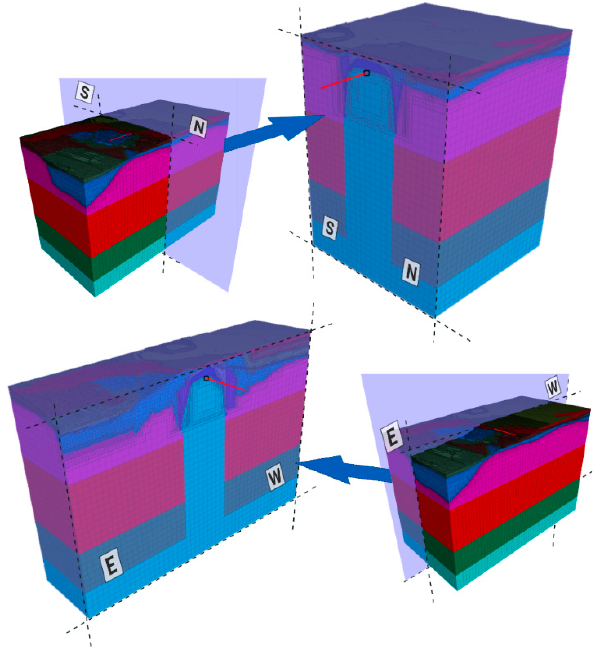
Figure 9. The location of the W–E and S–N cutting planes within the numerical model.